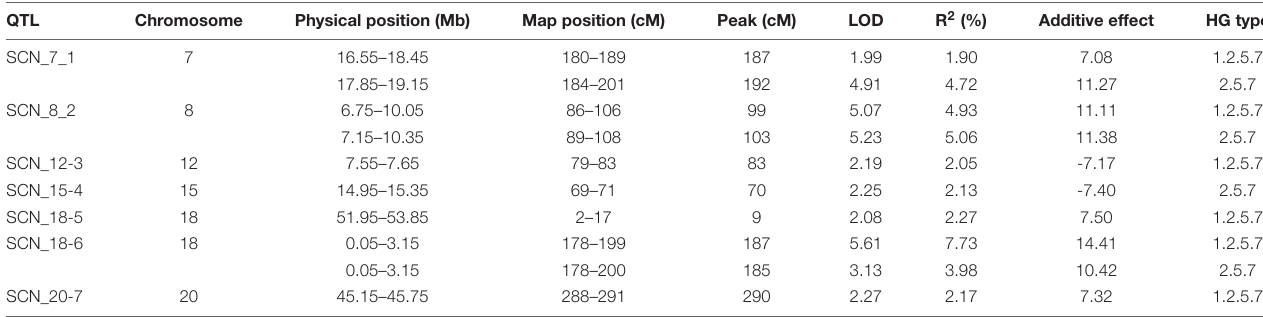
TABLE 4 | Summary of additive QTLs for SCN resistance detected in the mapping population of 392 RILs derived from the cross between susceptible parent Zheng 9525 and resistant parent Handou 10 using composite interval mapping (CIM) with the female index of HG types 2.5.7 (race 1) and 1.2.5.7 (race 2).